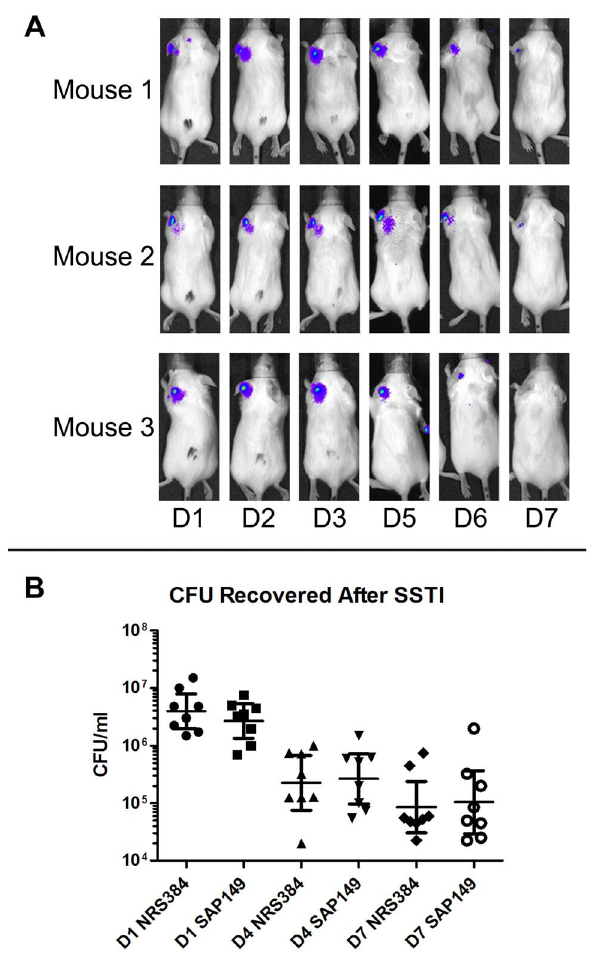
Figure 5. BALB/c skin and soft tissue infection with wild-type or luminescent NRS384. In a skin and soft tissue model (SSTI), mice were inoculated in the left ear with NRS384 or SAP149. Mice inoculated with SAP149 were imaged over the course of several days (A); images are representative. On days 1, 4, and 7 post infection, mice were euthanized and ear pinna homogenates were serially diluted and plated (B). There was no statistically significant difference in CFU recovered per ml of homogenate between mice infected with each strain (two-tailed t-test; P =0.55; bars represent 95% confidence interval; n=8 mice per